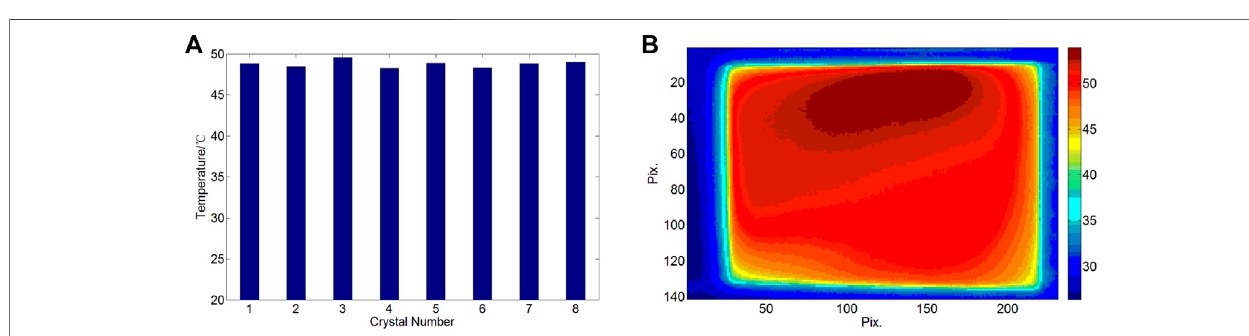
FIGURE 2 | (A) The average surface temperature. (B) A typical surface temperature distribution.